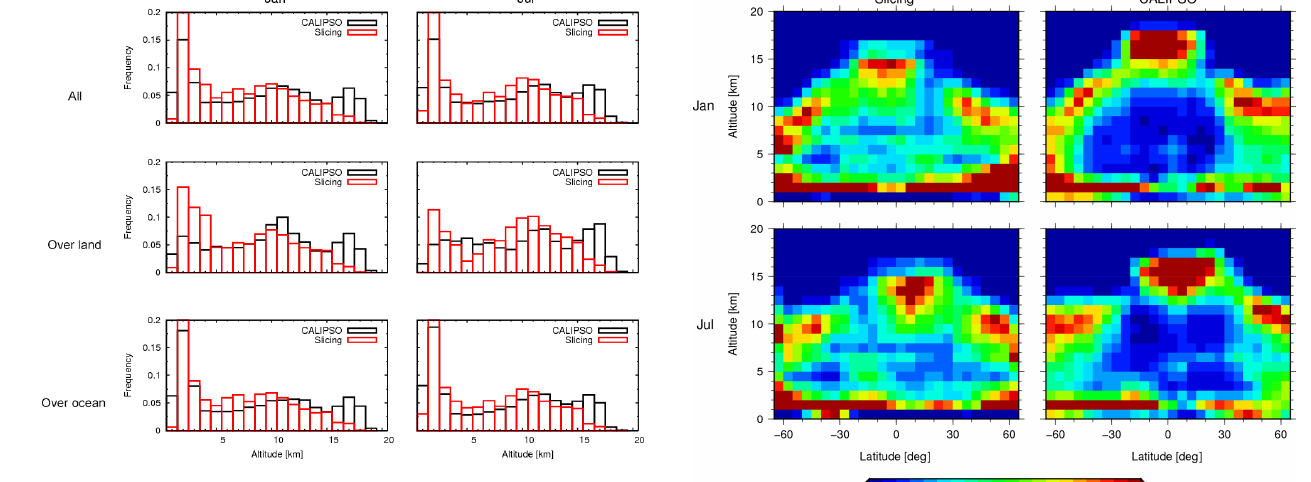
Figure 7. Vertical frequency distributions of CTHs from the slicing (red bars) and CALIPSO (black bars) over all surfaces (top), over land (middle), and over the ocean (bottom) in January (left column) and July (right column). Figure 8. Zonally averaged vertical distributions of monthly mean